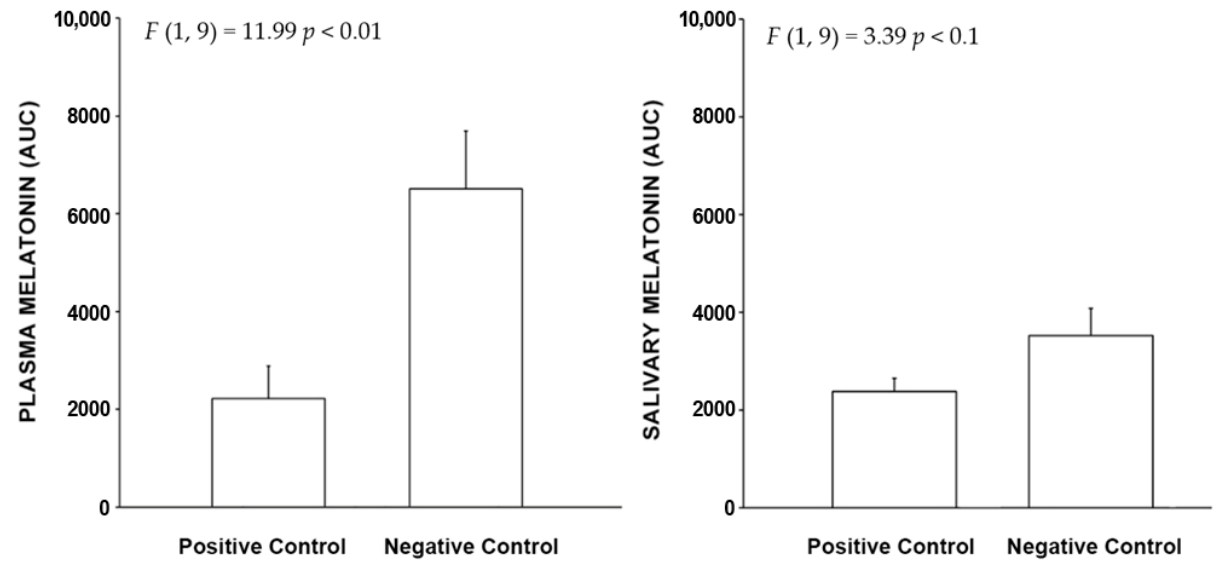
Figure 6. The bars shown above represent the mean (+ SEM) AUC plasma and salivary melatonin levels for the positive and negative control conditions in the laboratory portion of the light trespass study. The integrated melatonin AUC values were calculated from the plasma and salivary melatonin values shown in Figure 5 for the exposure period only (12:00 AM to–2:00 AM). The statistics are based on LMM.